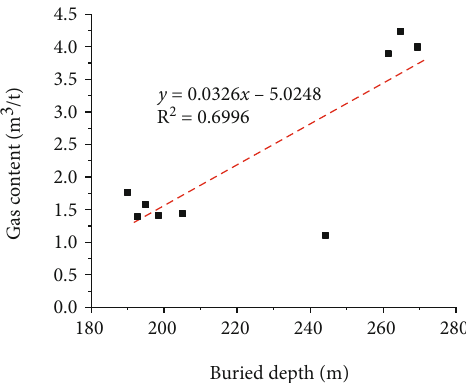
Figure 2: Regression trend line between gas content and coal seam buried